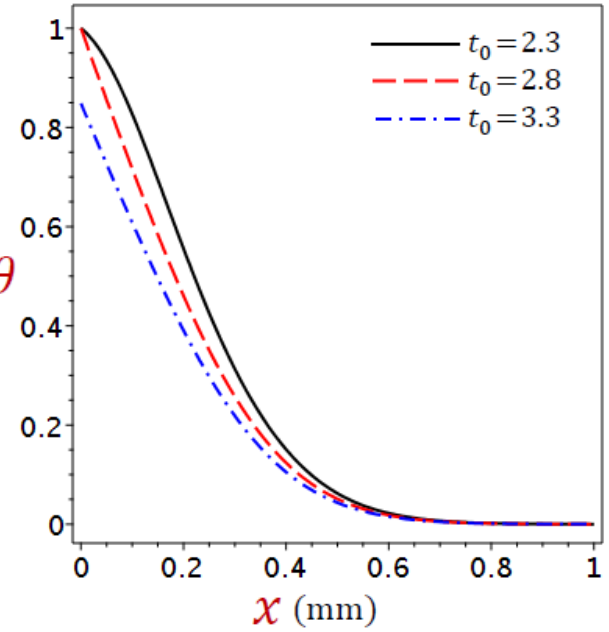
Figure 6. Variation of temperature ( θ ) across the skin tissue using numerous values of the ramp-time parameter for refined DPL model.